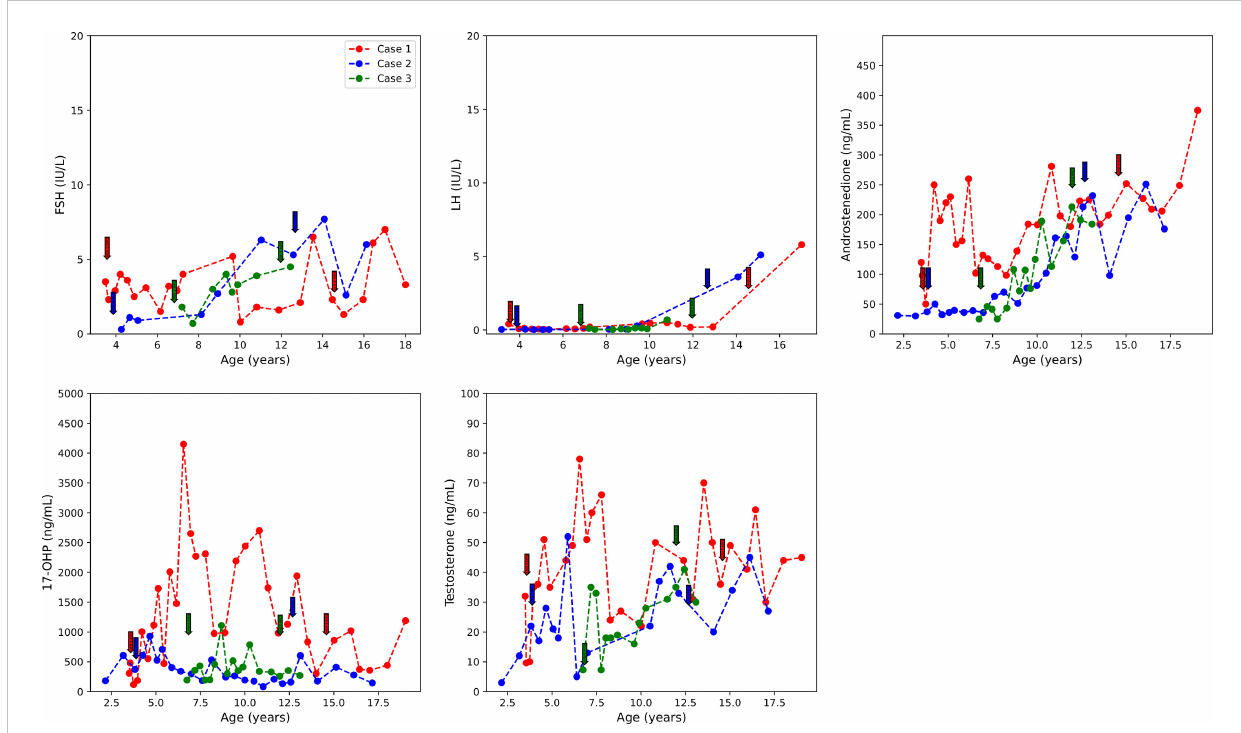
FIGURE 2 FSH, LH, D4A, 17-OHP, and testosterone concentrations over the course of treatment. Initiation and termination of treatment are indicated with colored arrows. D4A, androstenedione; 17-OHP, 17-hydroxyprogesterone. Initiation and termination of anastrozole treatment is indicated with